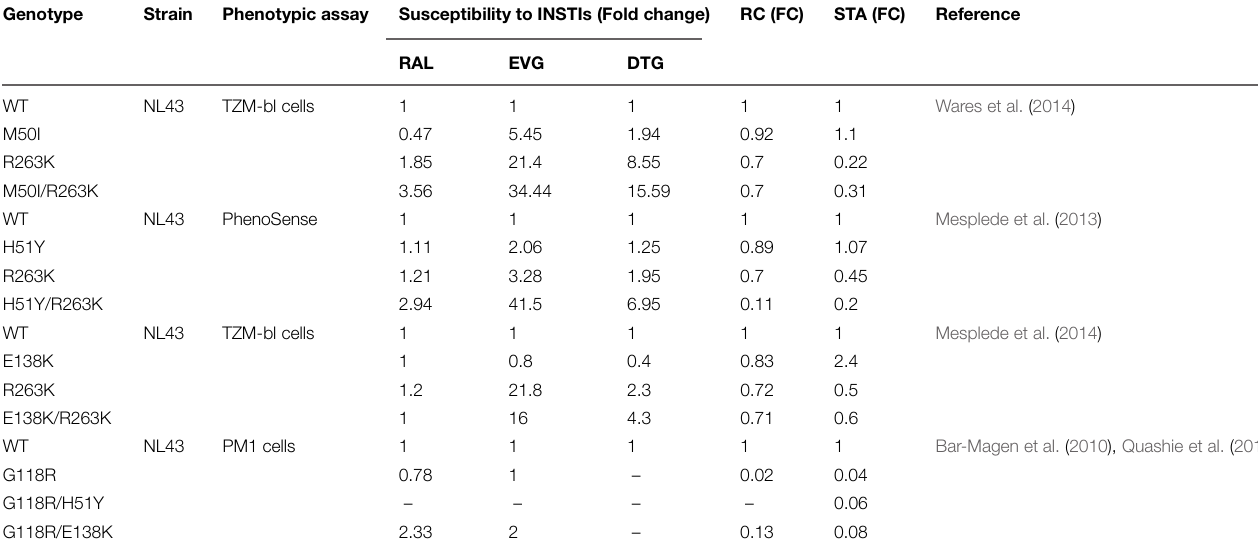
TABLE 2 | Effects of mutations in integrase on resistance to INSTIs, viral replication capacity (RC), and strand transfer activity. Genotype